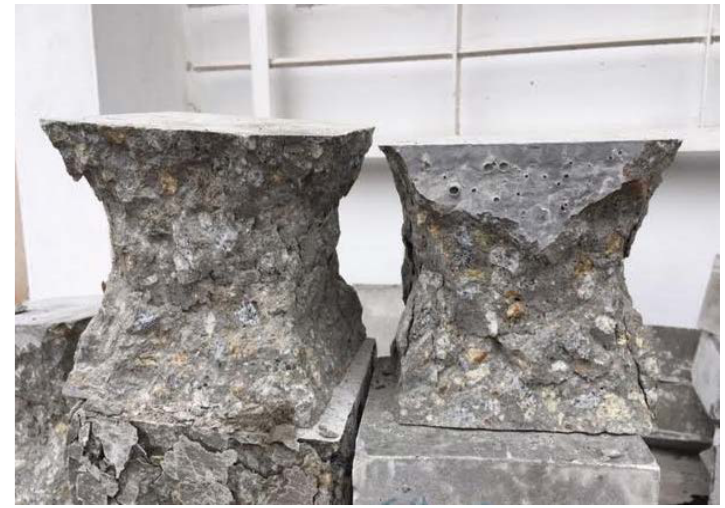
Figure 3. Concrete samples after compressive strength test.